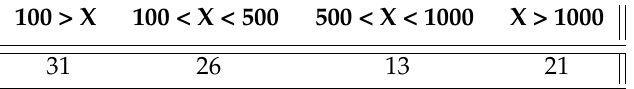
Figure 9. Size of scenarios used in experiments (in square